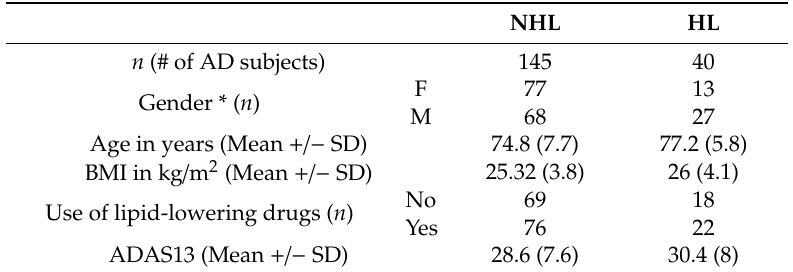
Table 2. Demographic variables. * p < 0.05. NHL = no hearing loss. HL = hearing loss. NHL HL n (# of AD